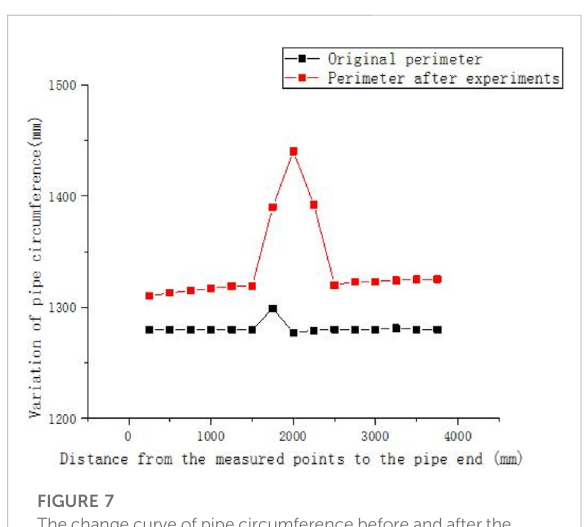
FIGURE 7 The change curve of pipe circumference before and after the